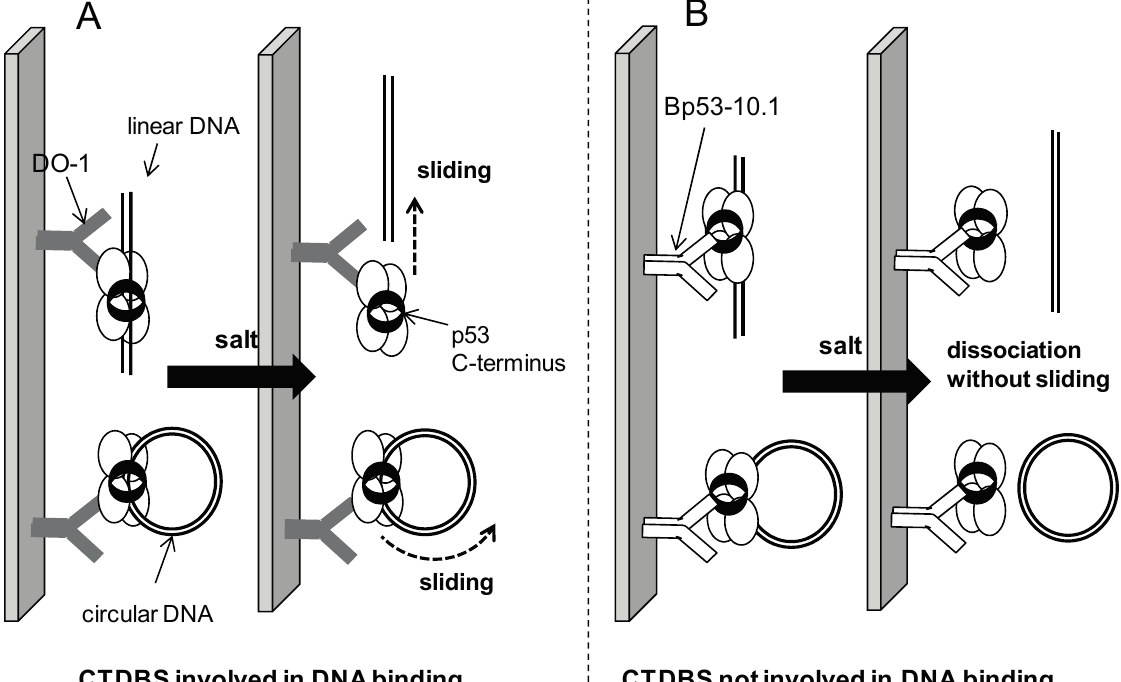
Figure 6. Scheme of possible mechanisms of dissociation of the p53 complexes with linear or circular DNAs for situations when the p53 CTDBS ( C -terminal DNA binding site) either is or is not involved. ( A ) In immune complexes with the DO-1 Ab, the CTDBS is available for interaction with DNA. The considerable stability of the corresponding p53 complexes with circular DNA substrates can be attributed to sliding (linear diffusion) mechanism as the major contribution of the dissociation process (even in high salt, the protein remains bound to DNA, sliding freely along it; linDNA can easily slide-out from the complex while the “endless” circular DNA cannot); and ( B ) When the CTDBS is blocked by the B-10 Ab, the (sequence non-specific) sliding mechanism does not take place, resulting in no differences between sc and lin DNA upon salt